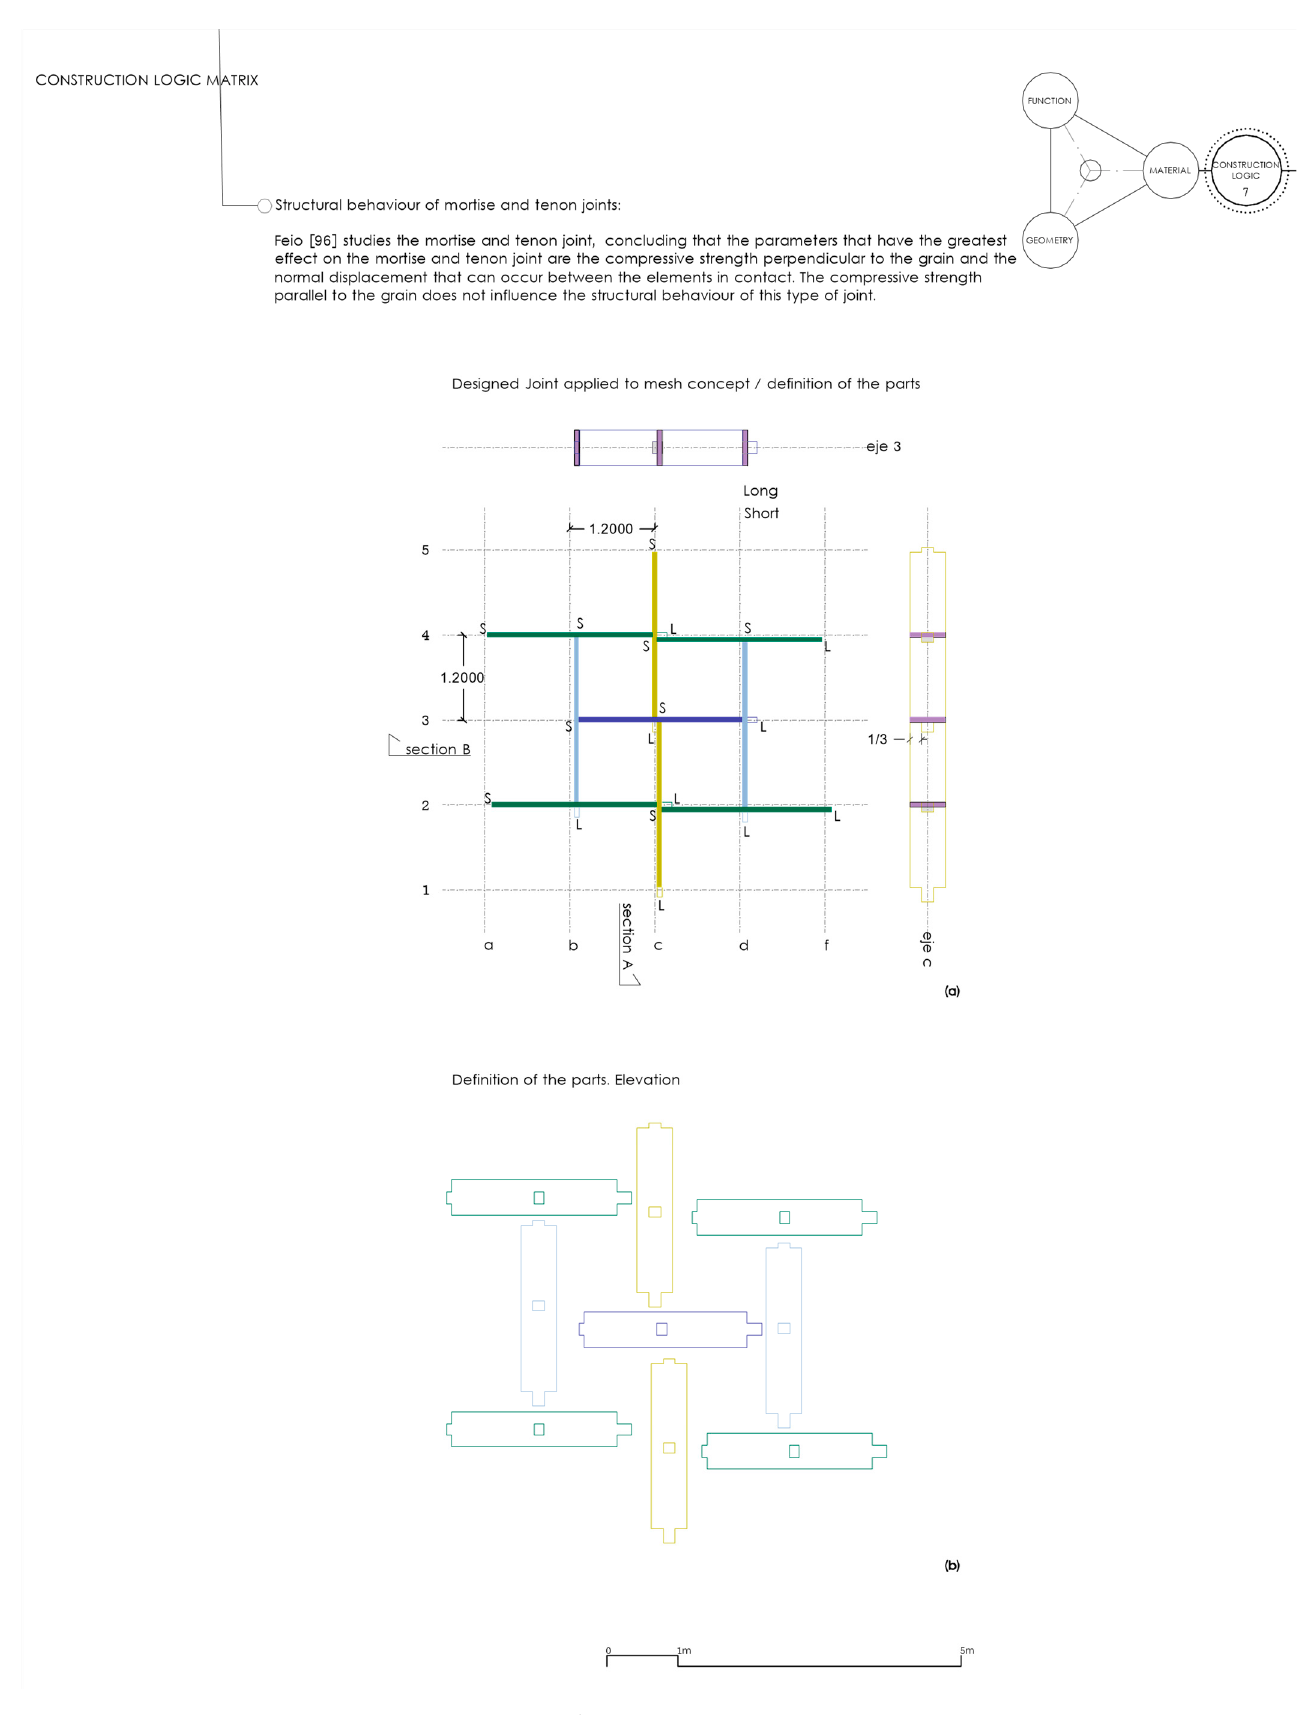
Figure 18. Construction logic matrix 7.